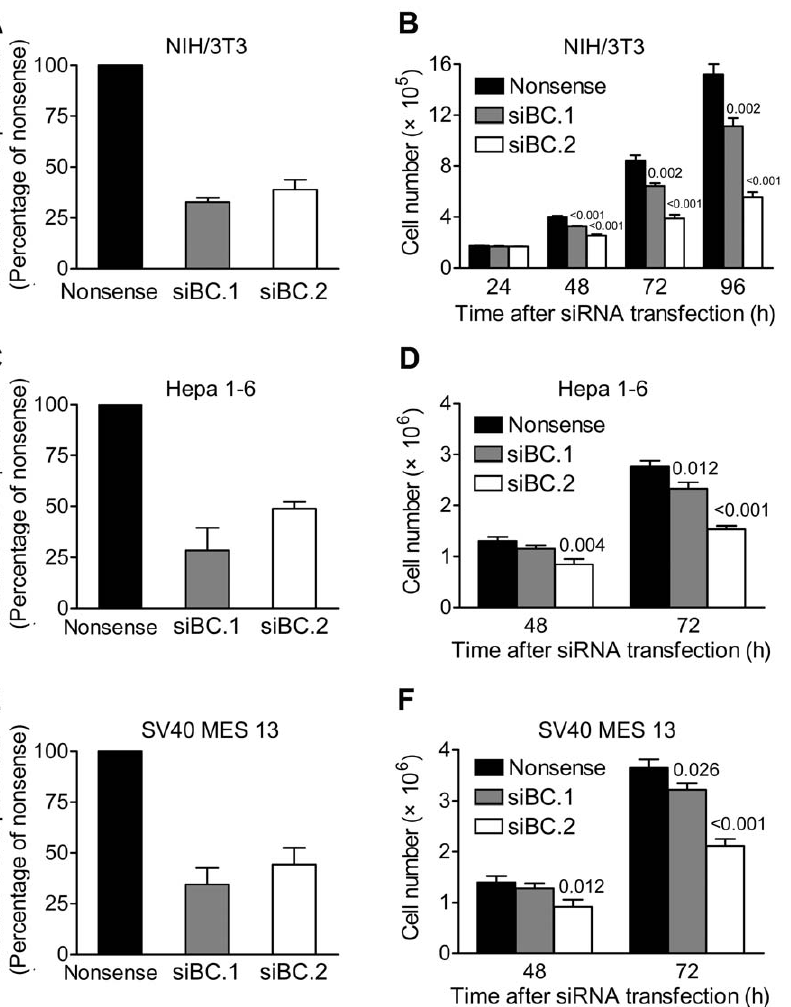
Figure 6. Down-regulating BC expression suppressed cell growth in several mouse cell lines. ( A, C and E ) Quantitative PCR results showing knock-down efficiency of BC siRNAs in NIH/3T3, Hepa 1–6 or SV40 MES 13 cells at 48 h after siRNA transfection. Data were mean 6 s.d. of at least three independent experiments. ( B, D and F ) Cell numbers of NIH/3T3, Hepa 1–6 and SV40 MES 13 cells at indicated times after siRNA transfection. Data were mean 6 s.d. of at least three independent experiments performed in triplicate. Values shown on top of bars are P values vs nonsense.